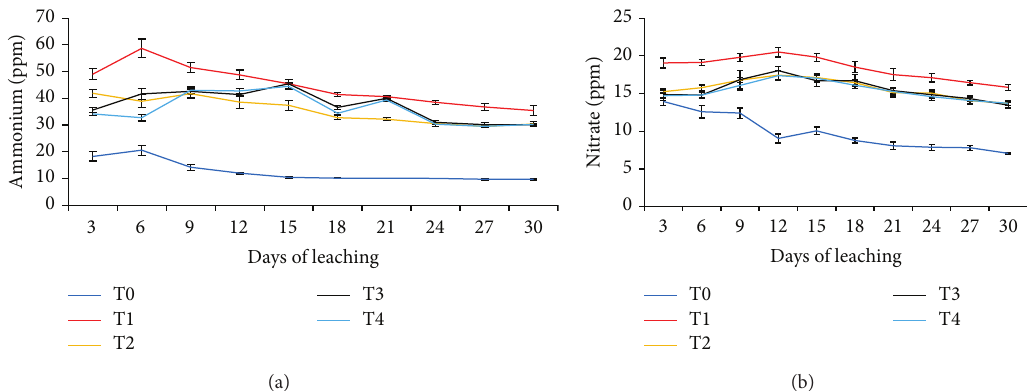
Figure 5: Ammonium and nitrate leached at three-day interval over 30 days of leaching experiment. Note . T0: 64 g soil (no urea); T1: 64 g soil + 7.40 g urea (no additives); T2: 64g soil + 7.40 g urea + 6g clinoptilolite zeolite; T3: 64 g soil + 7.40g urea + 1.54 g compost; T4: 64g soil + 7.40 g urea + 1.54g compost + 6g clinoptilolite zeolite. Note . Bar represents standard error of the mean.